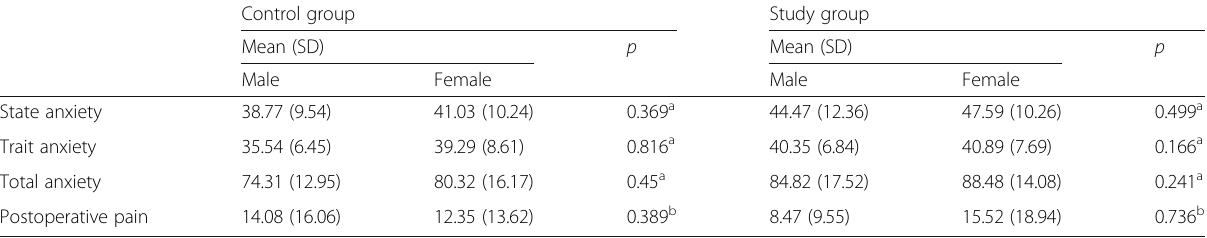
Table 4 Evaluation of anxiety and postoperative pain scores according to gender Control